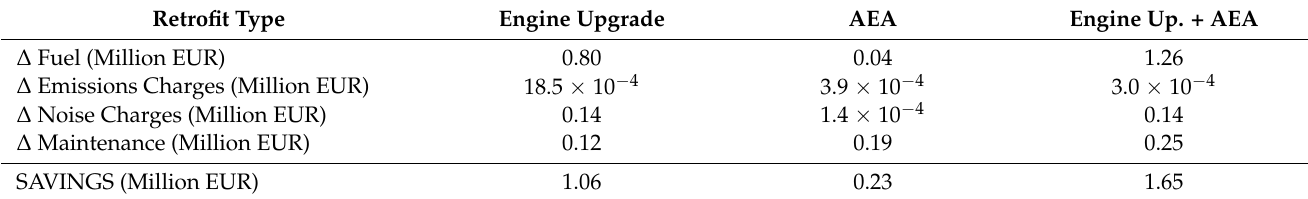
Table 14. The savings derived from three different retrofitting activities. The costs are expressed in million EUR per year and are related to a single aircraft belonging to a fleet composed of 300 units. Retrofit